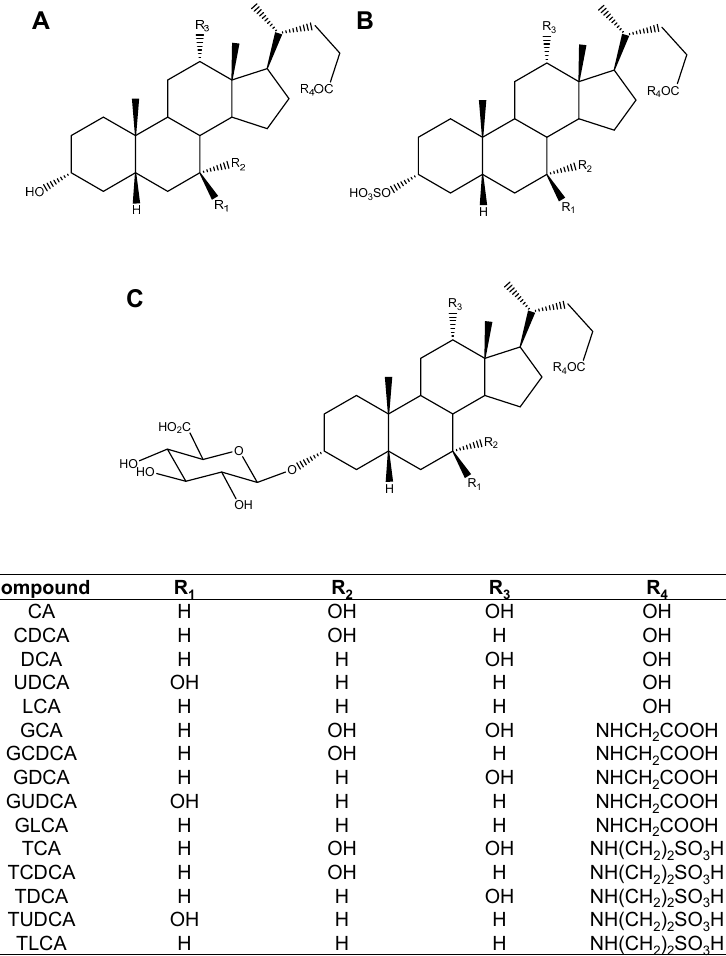
inhibition of the OATP4C1-mediated T 3 transport. The inhibition curves were drawn using JMP Pro 16, and the IC 50 values of LCA, GLCA, and TLCA for OATP4C1 were 6.12 ± 1.21, 9.90 ± 0.475, and 12.3 ± 0.891 µ M, respectively (Figure 3). The K i values of these bile acids calculated using Equation (1) were 5.23 ± 1.03 µ M for LCA, 8.46 ± 0.406 µ M for GLCA, and 10.5 ± 0.762 µ M for TLCA (Table